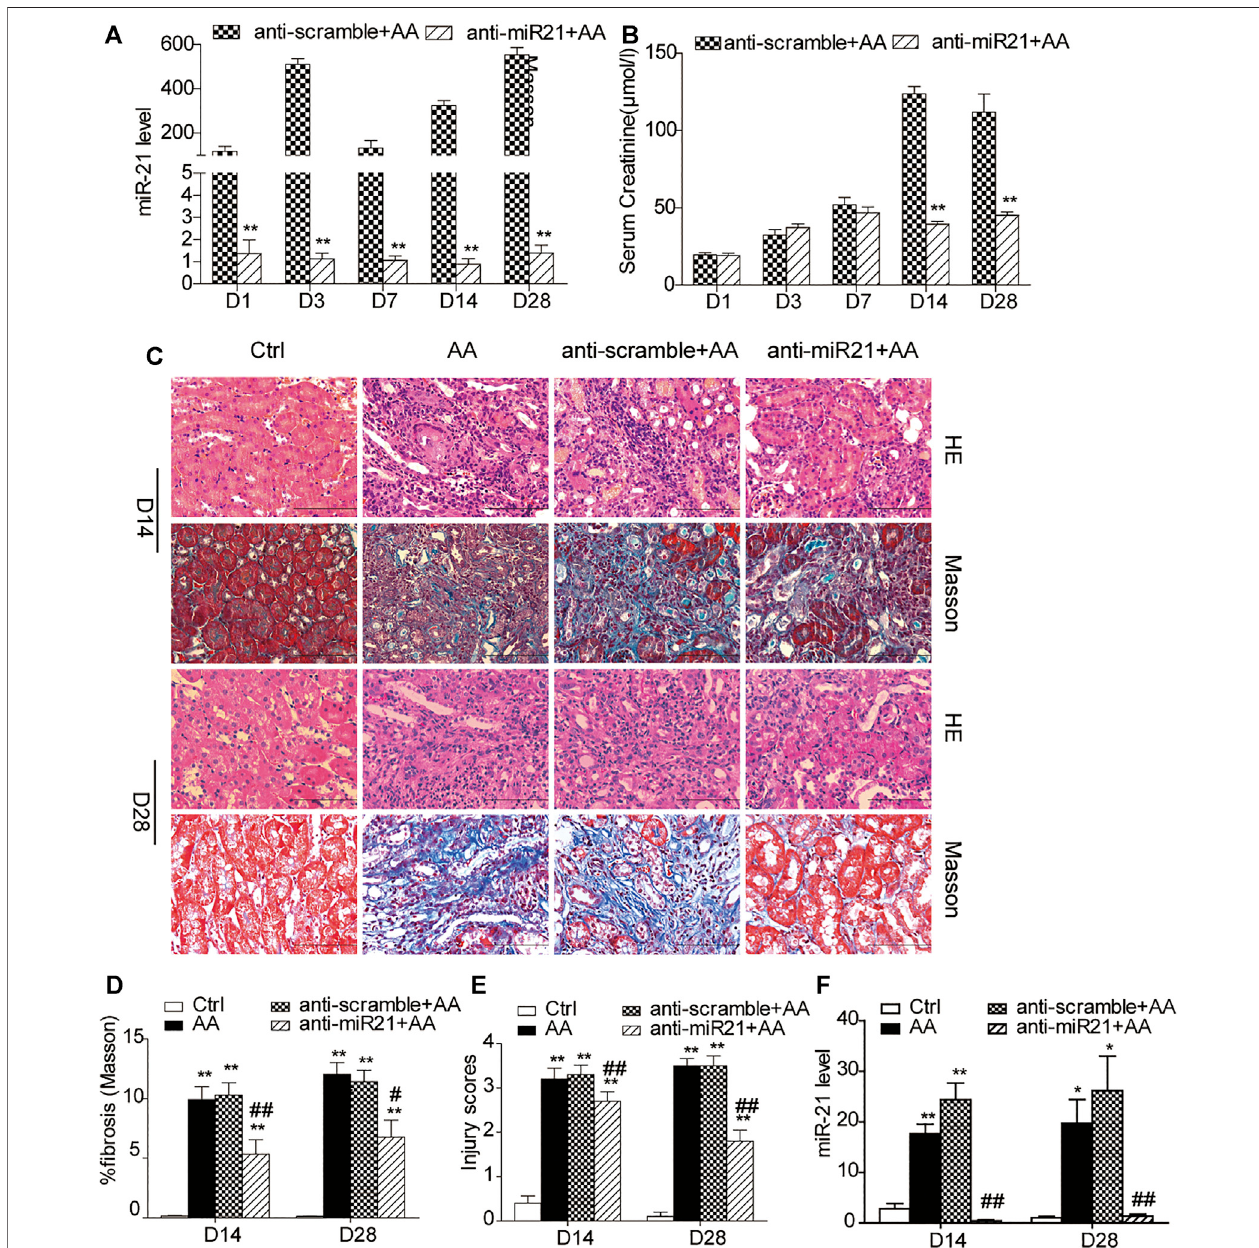
FIGURE 1 | Inhibition of miR ⁃ 21 partially reverses renal tubulointerstitial fi brosis induced by aristolochic acid. (A,B) RT-qPCR analysis of miR-21 abundance and serum levels ofcreatinine.Mice weresacri fi cedondays1,3,7,14,or28after aristolochic acid(AA)administration (10 mg/kg,i.p.). Lockednucleicacid-(LNA-) modi fi ed anti-miR21 oligonucleotides or anti-scramble was administered via the tail vein (10 mg/kg, 5 mg/ml) within 60 min prior to AA delivery. Additional injections (the same dose)weregivenonthe5 th and10 th dayafterAA-Idosing.* p < 0.05and** p < 0.01vs.anti-scramble+AAgroups, n (cid:2) 6. (C) H&EandMasson ’ strichromestaining of the corticomedullary junction (magni fi cation, 400 × , bar (cid:2) 200 μ m) on days 14 and 28 after AA delivery. (D,E) Histopathological assessment of H&E and Masson ’ s trichromestaining.Tenhigh-power fi eldsforeach mousewerecaptured,and thentheaveragenumber inthehigh-power fi eldswascalculatedforquanti fi cation. (F) The miR-21 abundance. * p < 0.05 and ** p < 0.01 vs. control groups (Ctrl). # p < 0.05 and ## p < 0.01 vs. anti-scramble + AA groups, n (cid:2) 6.